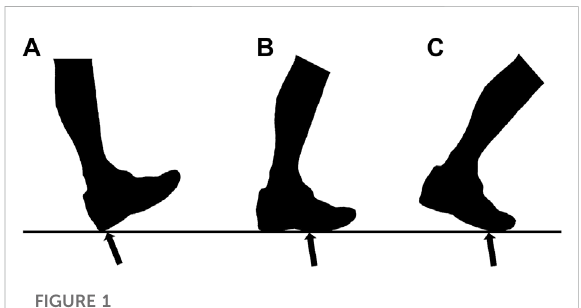
FIGURE 1 Three common types of foot strike pattern while running. (A) rearfoot strike pattern; (B) mid-foot strike pattern; (C) forefoot strike pattern.